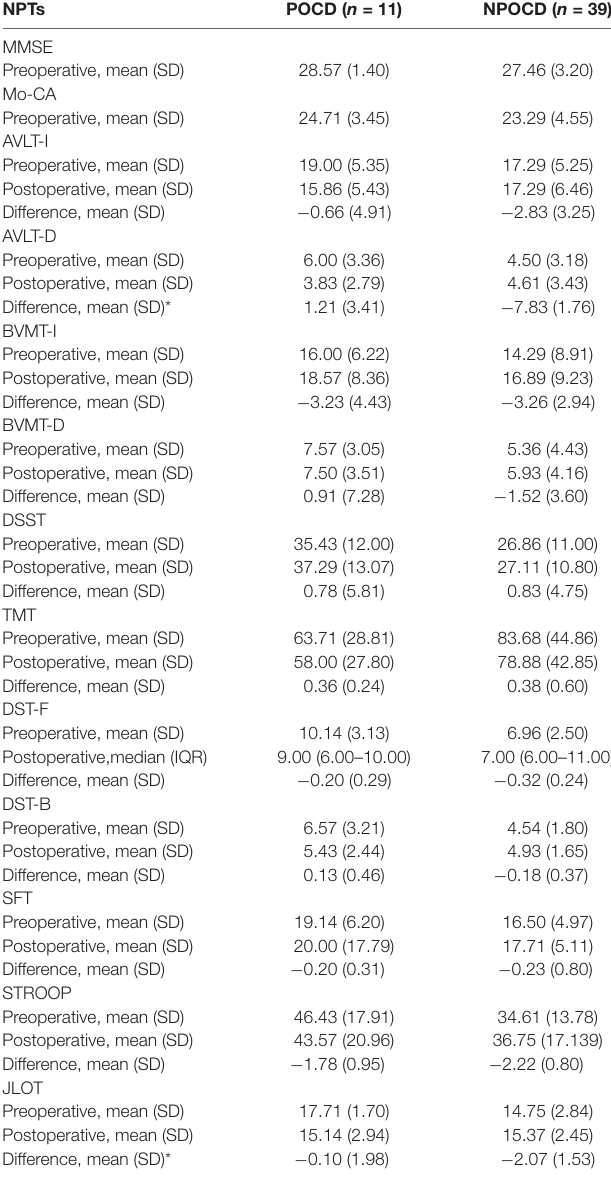
TABLE 3 | Summary statistics of patients with and without POCD in different cognitive function